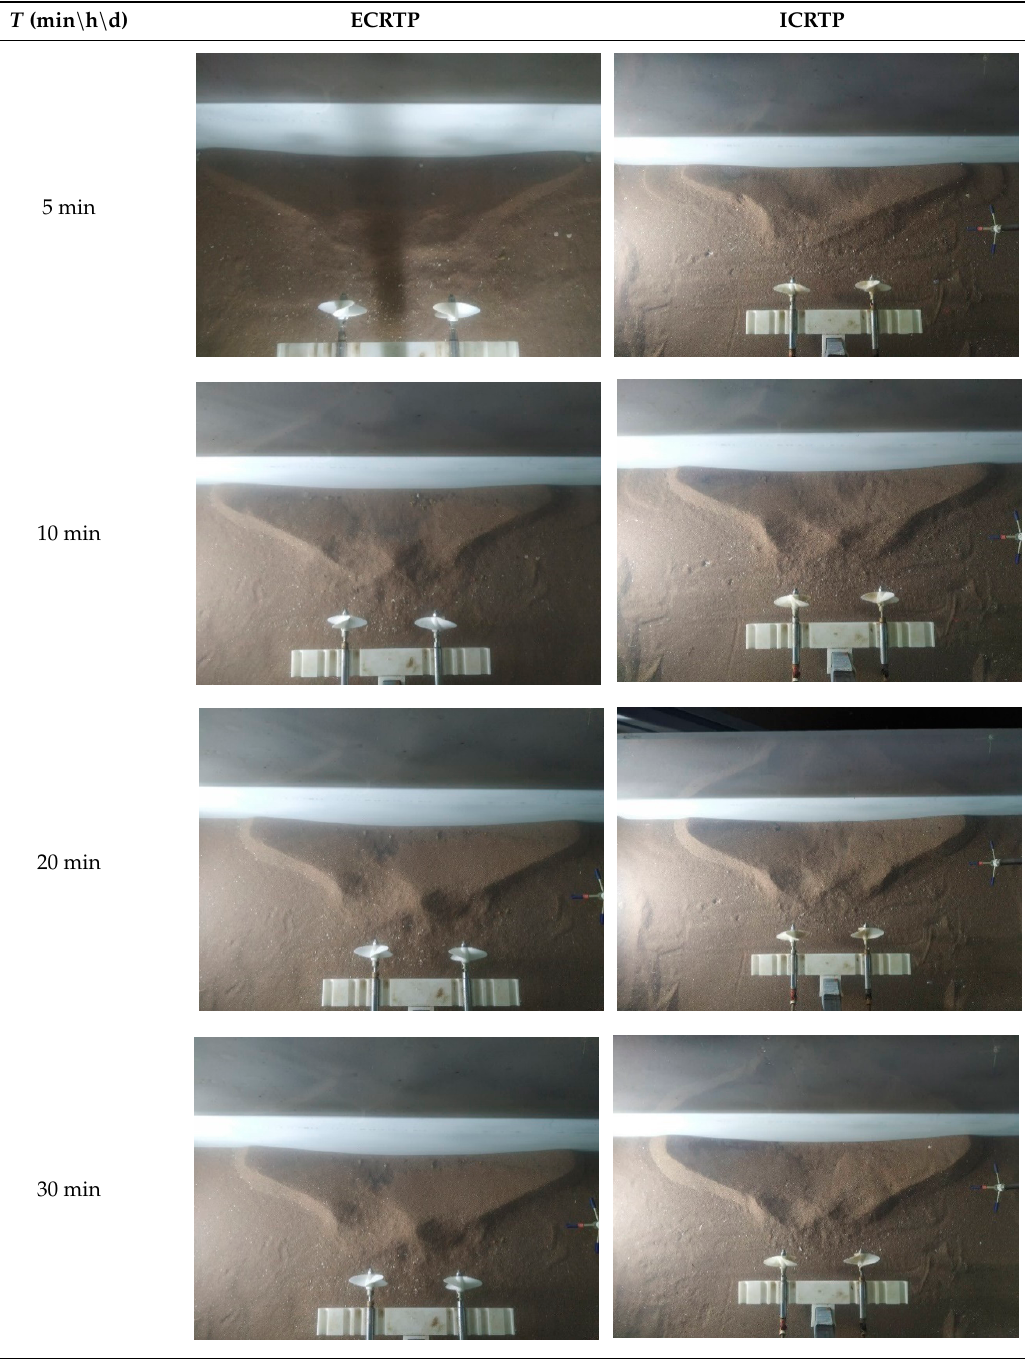
Table 3. Scouring process.